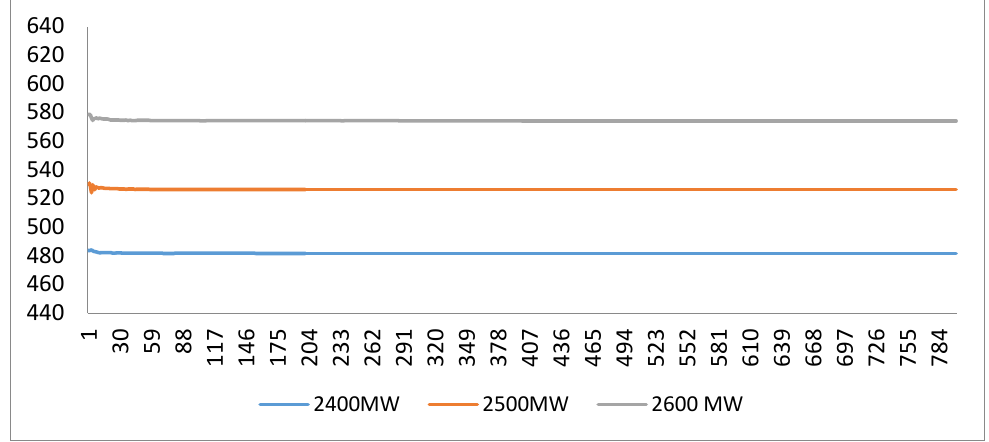
Figure 7. Convergence-characteristics of SBE algorithm for system 1 (without valve point loading effects), P d = 2400 MW, 2500 MW, 2600 MW.